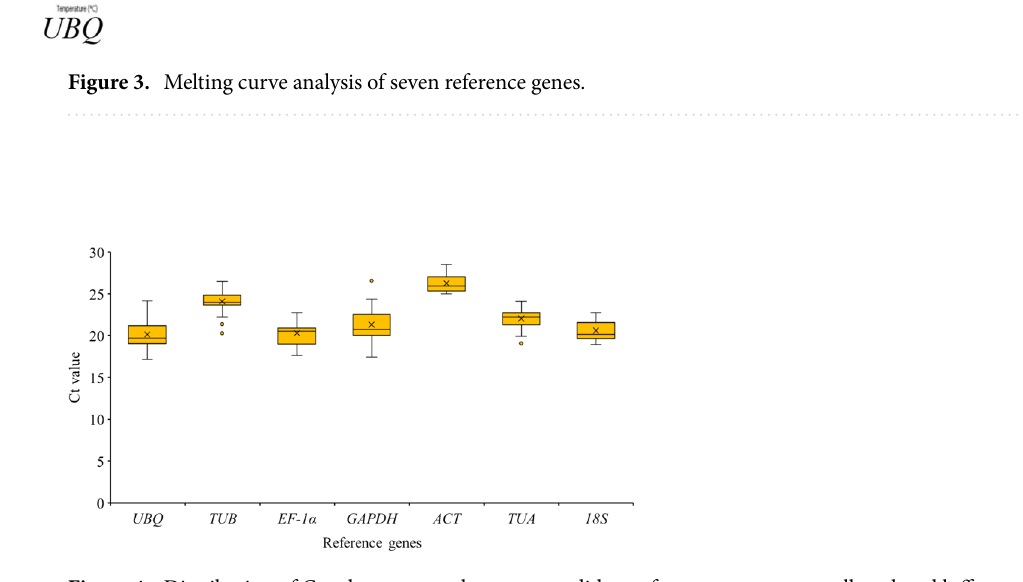
Figure 4. Distribution of Ct values among the seven candidate reference genes across all analyzed luffa samples. The box indicates the 25th and 75th percentiles, with the line across the box representing the median. The whiskers and asterisks represent the 95% confidence intervals and outliers,